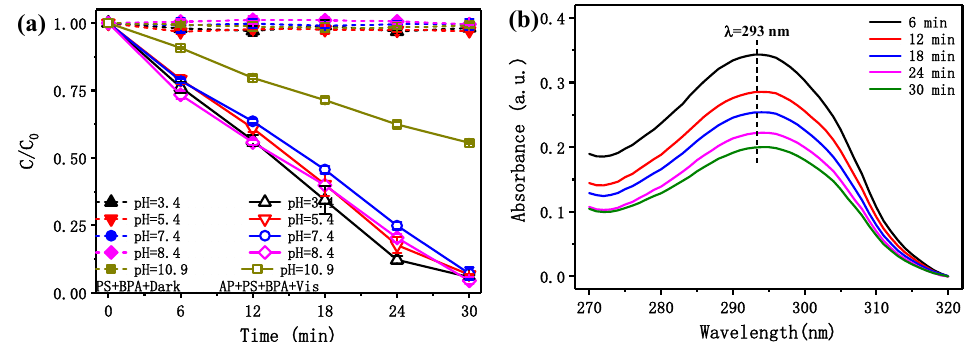
Figure 10. ( a ) DMPO spin trapping EPR spectra with Ag 3 PO 4 as catalyst in aqueous dispersion for DMPO– • OH and DMPO– • O 2 − under visible light irradiation or under the condition of darkness; ( b ) DMPO spin trapping EPR spectra with Ag 3 PO 4 and potassium persulfate as catalysts or with Ag 3 PO 4 as catalyst in aqueous dispersion for DMPO–SO 4• − , DMPO– • OH and DMPO– • O 2 − under visible light irradiation.